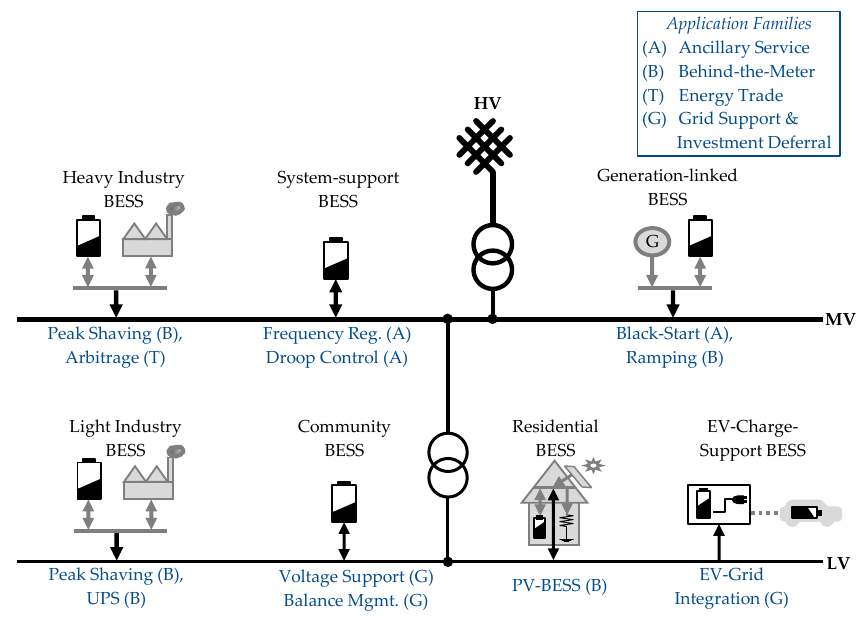
Figure 7. Variant types of stationary battery storage systems (black color) grouped according to their integration to Low-Voltage (LV) and Medium-Voltage (MV) grid levels. Typical applications are listed in blue color, letters in brackets link to application families as defined in the figure legend. Overlying High-Voltage (HV) connection and transformer links are depicted schematically.